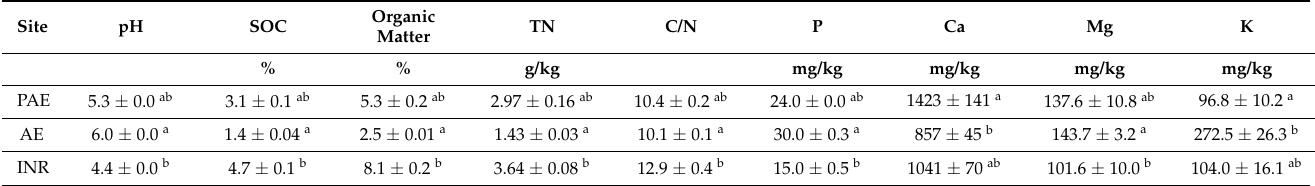
Chemical analysis of soil samples taken from the Polluted AgroEcosystem (PAE) AgroEcosystem (AE), and the integral natural reserve (INR). The values displayed are the mean values ± standard deviation. Values with different letters in the same column are signifi- cantly different ( p < 0.05, ANOVA test).